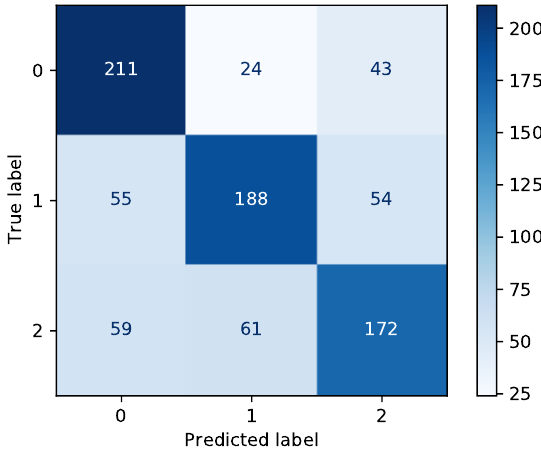
Figure 6. Confusion matrix for case study